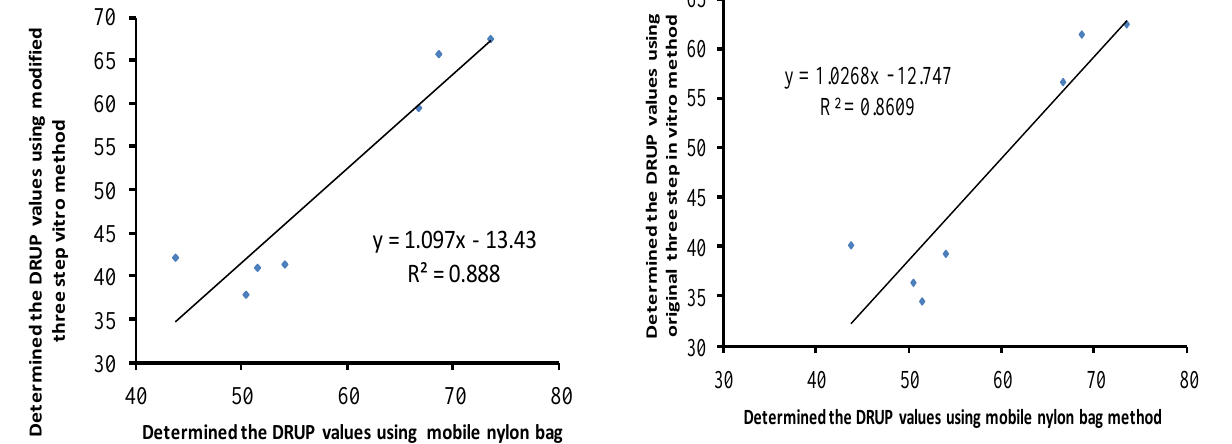
Figure 4. Predicted analysis between MNB observed values and OTS observed value in the roughages. DRUP, digestibility of rumen undegradable protein; MNB, mobile nylon bag method; OTS, original three-step in vitro